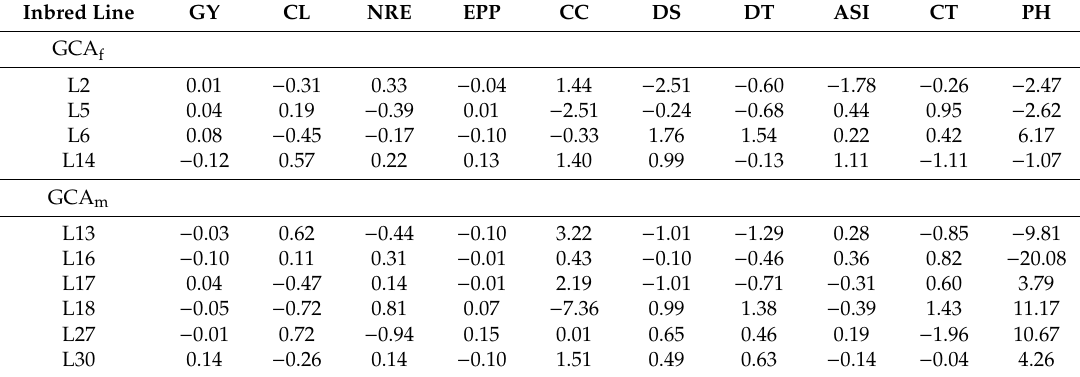
Table 5. General combining ability e ff ects for yield, yield components and other morpho-agronomic traits under combined drought and heat stress conditions. Inbred Line GY CL NRE EPP CC DS DT ASI CT